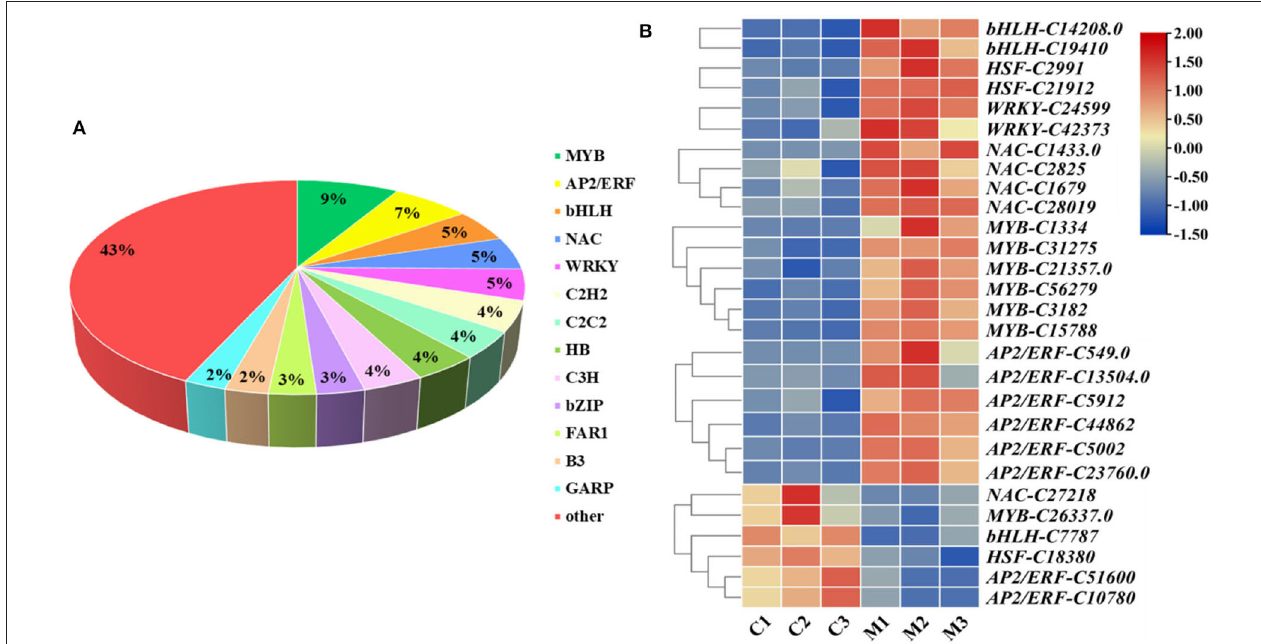
FIGURE 7 | Analysis of differentially expressed TFs related to low-temperature stress. (A) Distribution of TF families in the transcriptome in M. microcarpa leaves. (B) Expression profiles of differentially expressed TFs. Changes in expression level are indicated by a change in color, blue indicates a lower expression level, whereas red indicates a higher expression level. C, samples treated at 25 ◦ C; M, samples treated at − 2.8 ◦